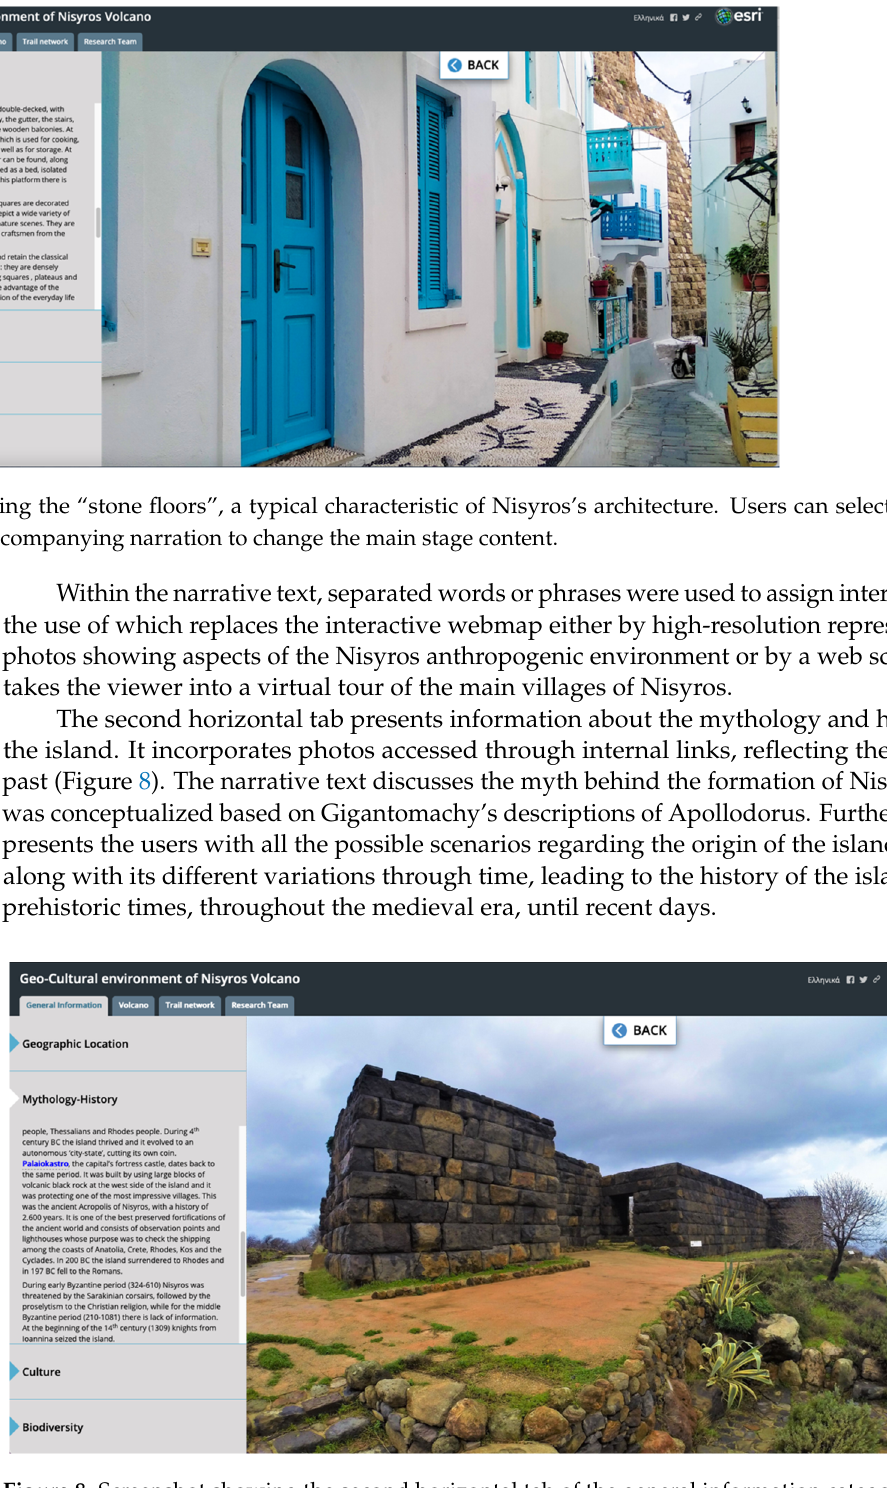
Figure 8 . Screenshot showing the second horizontal tab of the general information